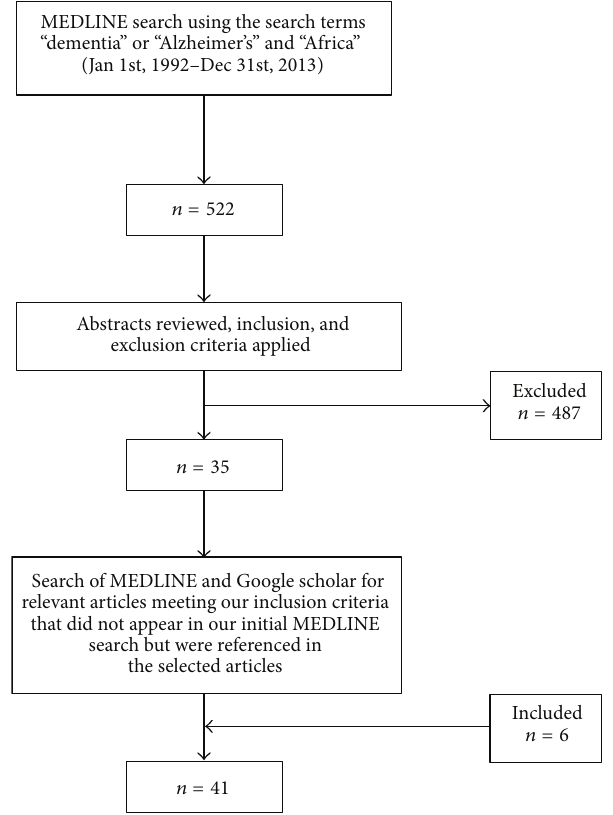
Figure 1: Flow chart of search methodology used to identify rele- vant population and hospital-based studies on the epidemiology of dementia in